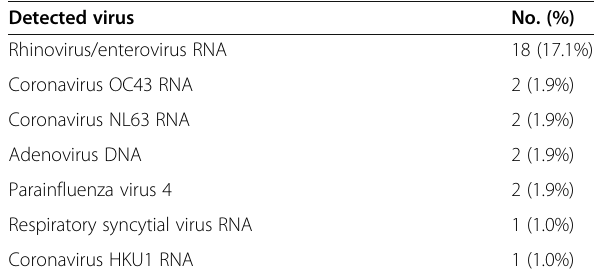
Table 2 Categories of pathogens of 105 patients who received non-COVID-19 pathogen examinations Detected virus No. (%) Rhinovirus/enterovirus